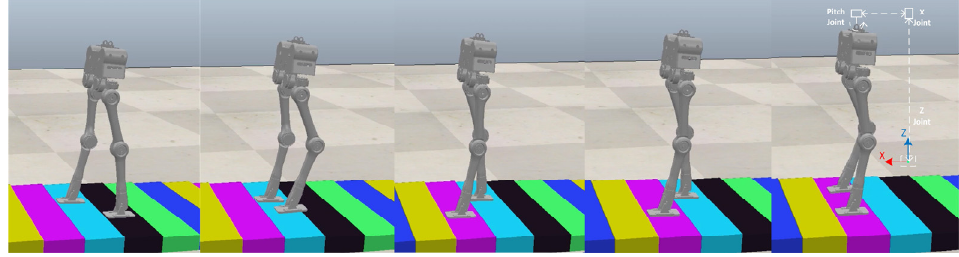
Figure 10. Five key frames of stairs terrain walking in CoppeliaSim.